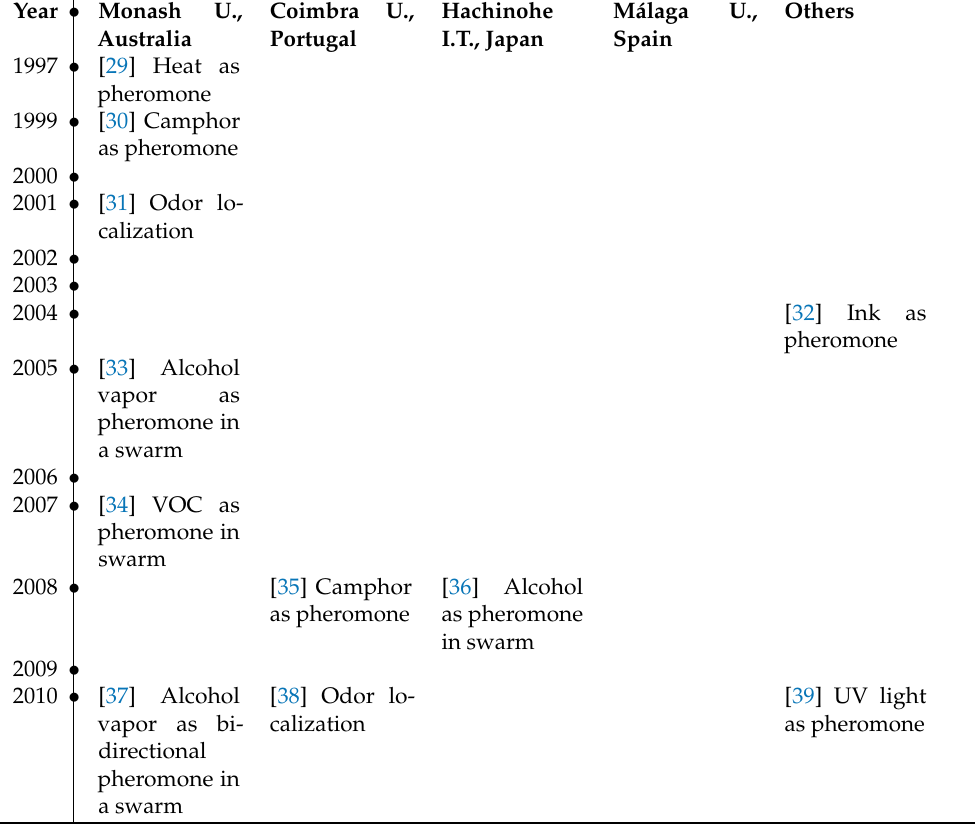
Table 1. Timeline of publications and research groups related to real implementation of robot